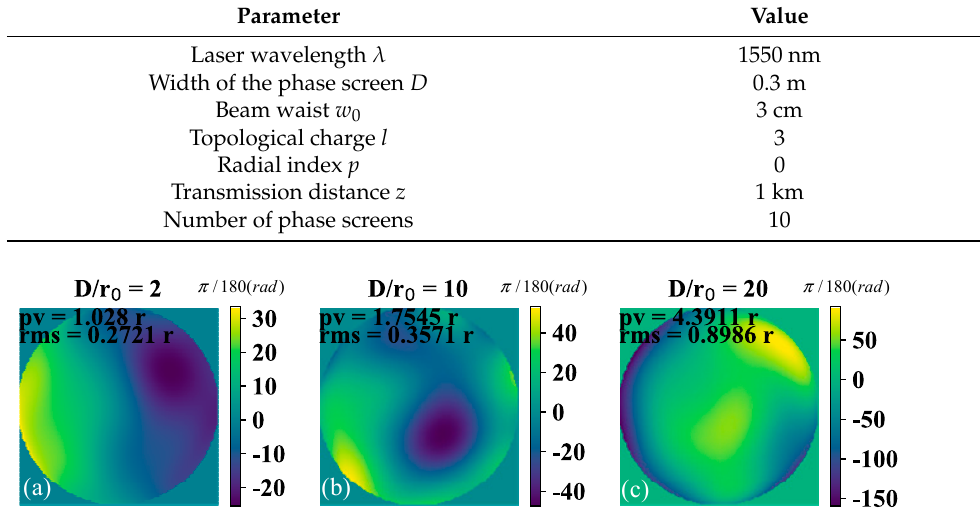
Table 1. Parameter of simulation.